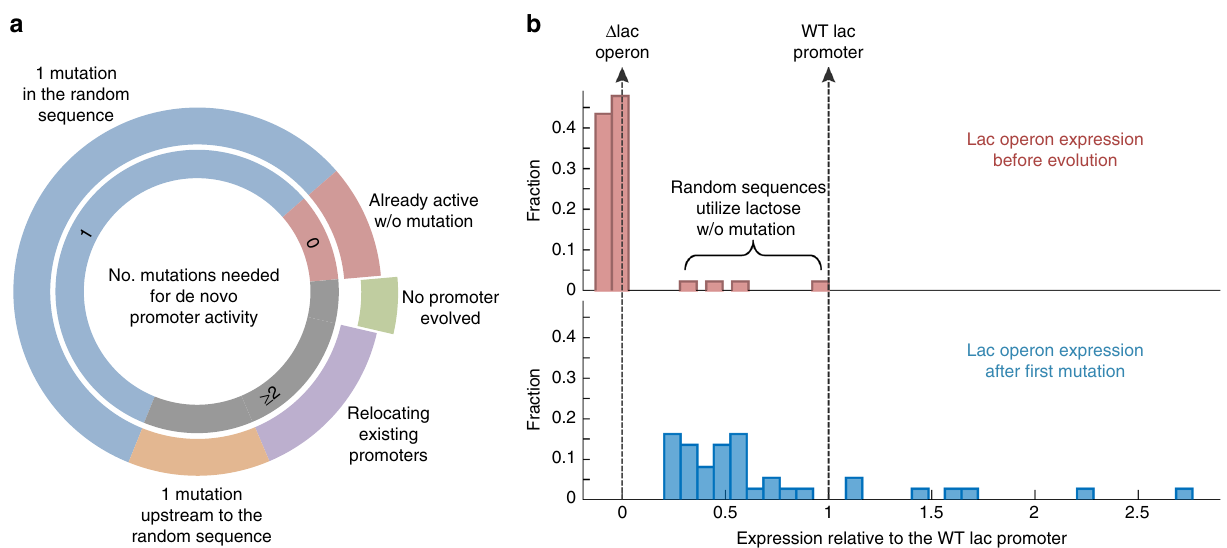
Fig. 3 A typical random sequence of ~100 bases requires only one mutation to evolve into a promoter. a A summary of 40 different random sequences and the different type (outer circle) and number (inner circle) of mutations needed to transform a random sequence to a functional promoter. Zero represents random sequences that were active already before any adaptation and ≥ 2 represent random sequences that require two or more mutation, in which we include all the library strains that could not evolve the expression via mutations in the random sequences. ~10% of random sequences require no mutation for expression of the lac genes (red segment). For 57.5% of random sequences, a single mutation found within the random sequence enabled expression of the lac genes (similar to RandSeq 1, 2, and 3 shown earlier) (blue segment). Other strains either relocated an existing promoter from another locus in the genome to be upstream to the lac promoter (15%, purple) or found point mutations in the intergenic region upstream to the random sequence (12.5%, orange). b Expression of the lac genes before evolution and after the fi rst mutation that was associated with the ability to utilize lactose (upper and lower panel, respectively). YFP reads normalized to OD600 are shown. Expression level of 1 is de fi ned as the expression measured from the WT lac promoter (right vertical dashed line), and 0 is de fi ned as the background read of the control strain Δ LacOperon in which the lac operon is deleted and no YFP gene was integrated (left vertical dashed line). The ~10% of random sequences that conferred the ability to utilize lactose even before evolution is found to